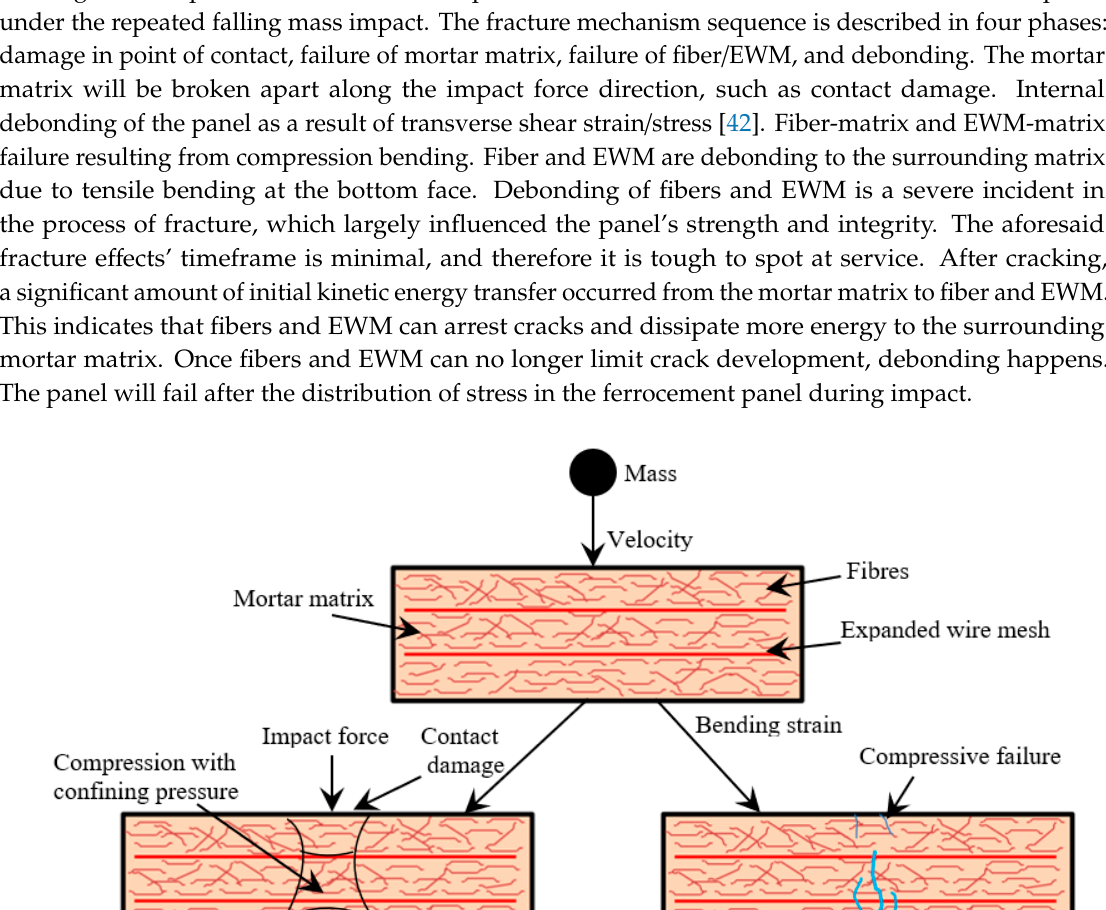
Figure 14. Distribution of fibers in ferrocement panel: ( a ) random and ( b ) planar.